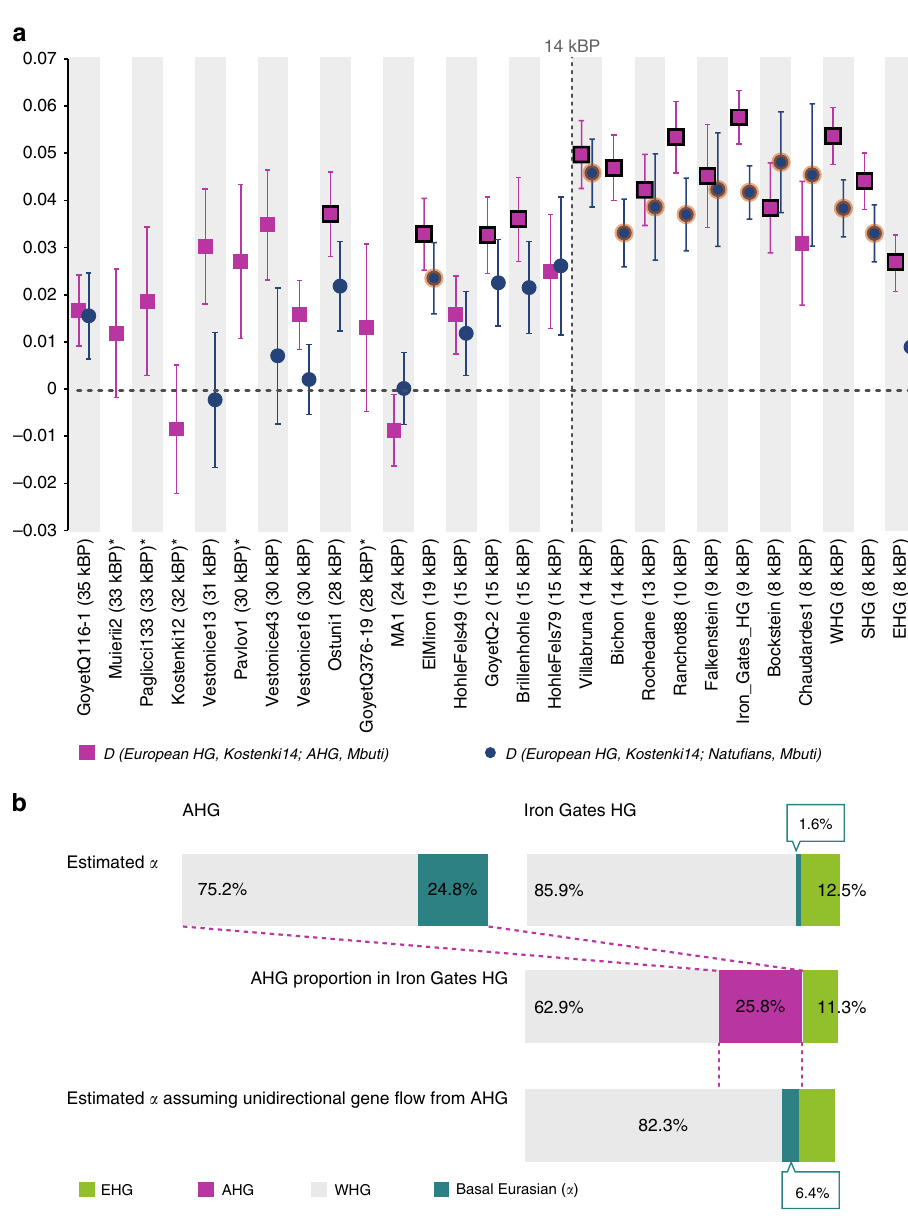
Fig. 3 Genetic links between Near-Eastern and European hunter-gatherers. a Genetic af fi nity between Near-Eastern and European hunter-gatherers increases after 14,000 years ago as measured by the statistic D(European HG, Kostenki14; Natu fi an/AHG, Mbuti) . Vertical lines mark ± 1 SE. Data points for which D > 3 SE are outlined. Kostenki14 serves here as a baseline for the earlier European hunter-gatherers. Statistics including all analyzed European hunter-gatherers are listed in Supplementary Data 5. Individuals marked with an asterisk did not reach the analysis threshold of over 30,000 single- nucleotide polymorphisms (SNPs) overlapping with Natu fi an/AHG . b Basal Eurasian ancestry proportions ( α ) as a marker for Near-Eastern gene fl ow. Mixture proportions inferred by qpAdm for the Anatolian hunter-gatherer (AHG) and the Iron Gates hunter-gatherers (Iron Gates HG) are schematically represented 6 . The lower schematic shows the expected α in Iron Gates HG under assumption of unidirectional gene fl ow, inferred from α in the AHG source population. The observed α for Iron Gates HG is considerably smaller than expected; thus, the unidirectional gene fl ow from the Near East to Europe is not suf fi cient to explain the af fi nity between Iron Gates HG and AHG. Source data are provided as a Source Data fi